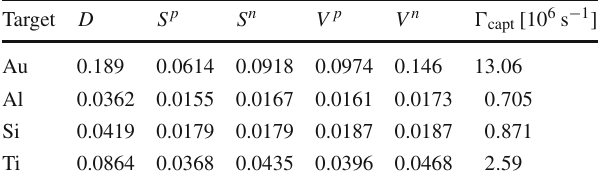
Table 10 Numerical values of the dimensionless coefficients D , S p , n , V p , n and the muon capture rate for different nuclei Target